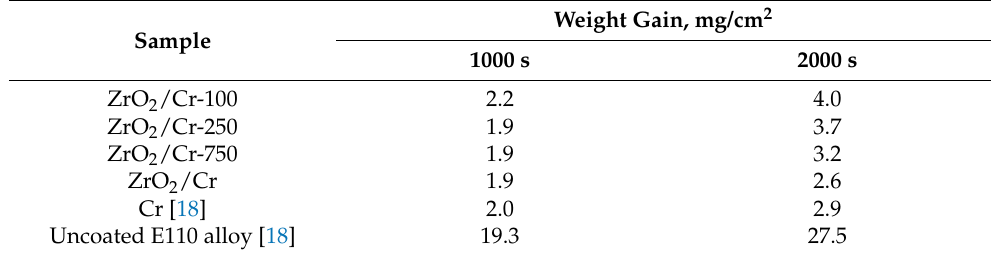
Table 3. The weight gains of the samples after oxidation in a steam at 1200 ◦ C for 1000 and 2000 s.